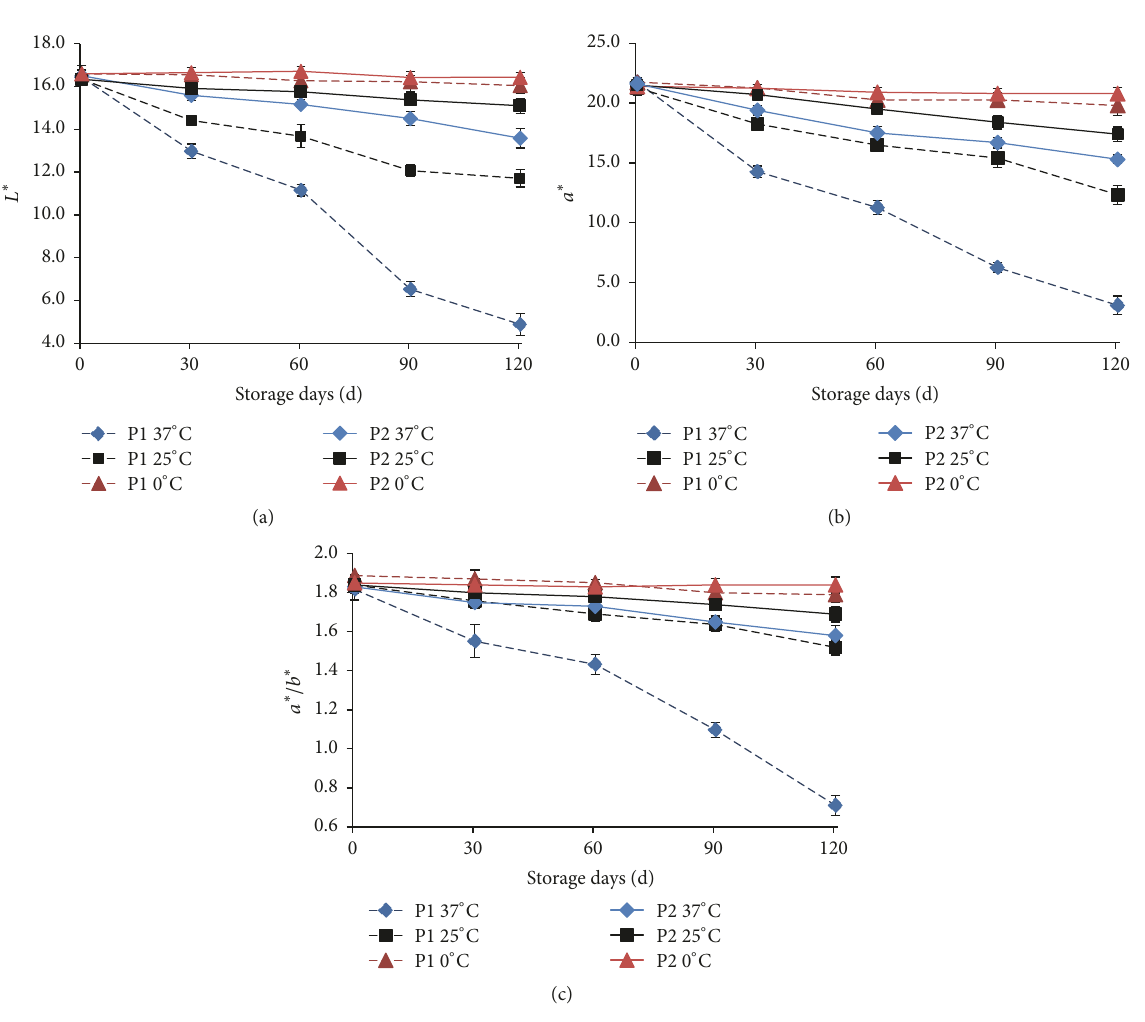
Figure 4: Changes of 𝐿 ∗ (a), 𝑎 ∗ (b), 𝑎 ∗ /𝑏 ∗ (c) in THPS during storage. The experiments were performed in triplicate, and results were expressed as the means ± standard deviation